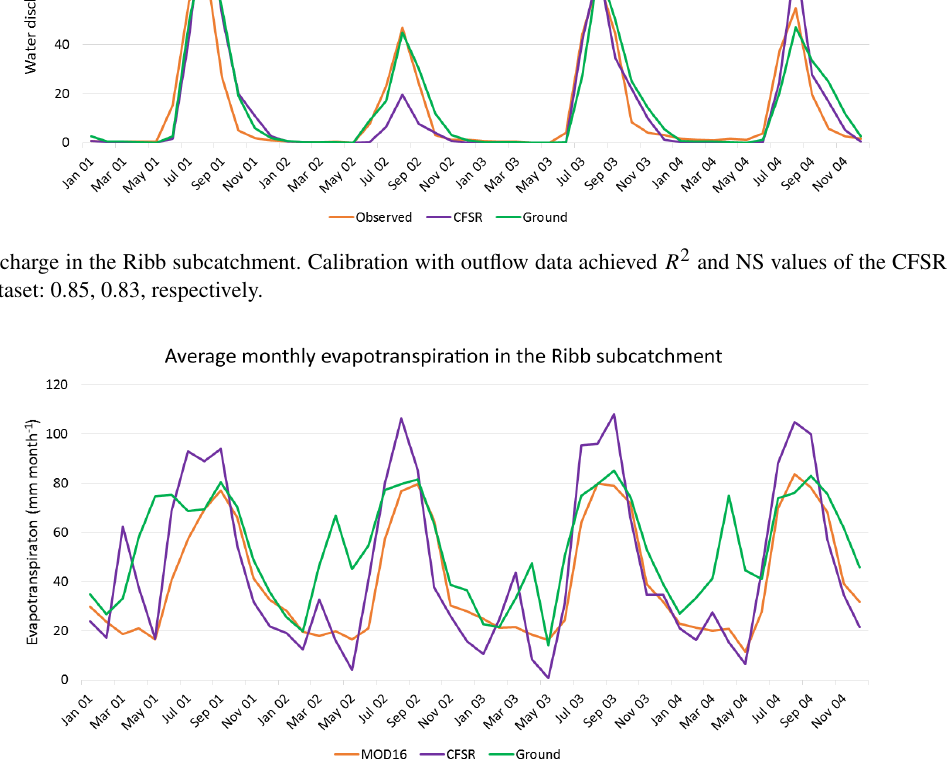
Figure 14. Average monthly evapotranspiration in the Ribb subcatchment. Statistical results achieved R 2 and NS values of the CFSR dataset: 0.78, 0.47; and ground dataset: 0.59, 0.24, respectively, compared to the MOD16